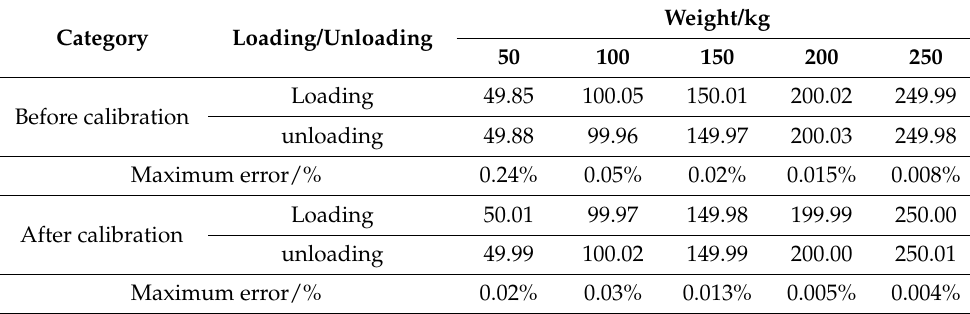
Table 1. Pressure sensor calibration test measurement results.